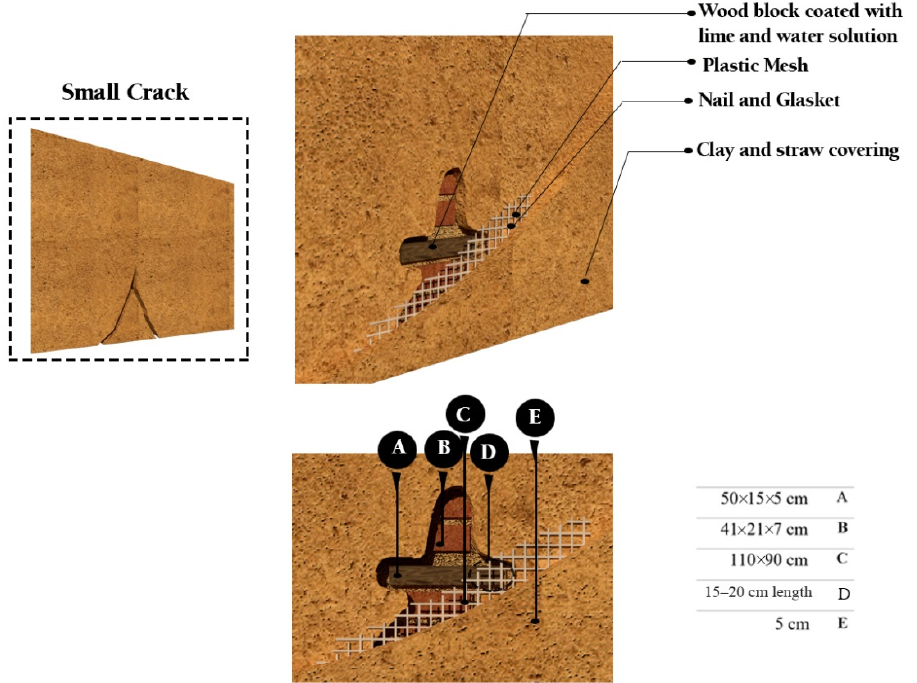
40 cm width). Figure 7. Example of architectural detail for conservation of a small crack in the wall (for instance,